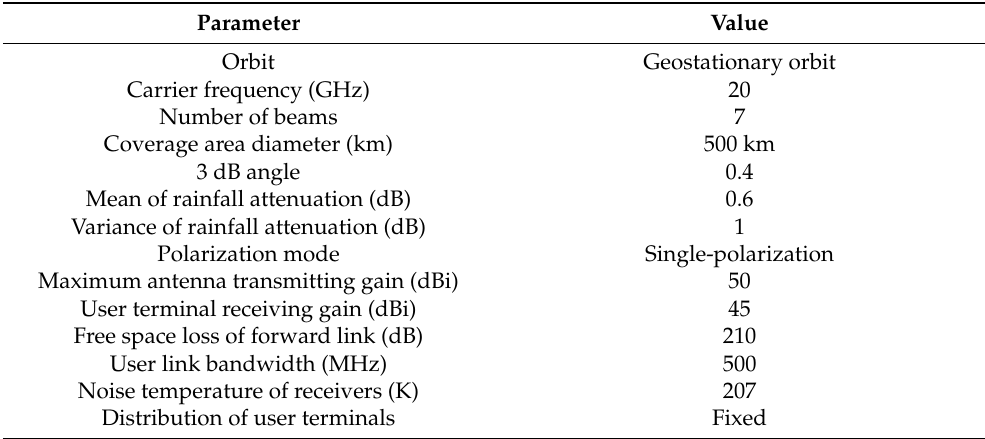
Table 1. Parameters of a high throughput satellite communications